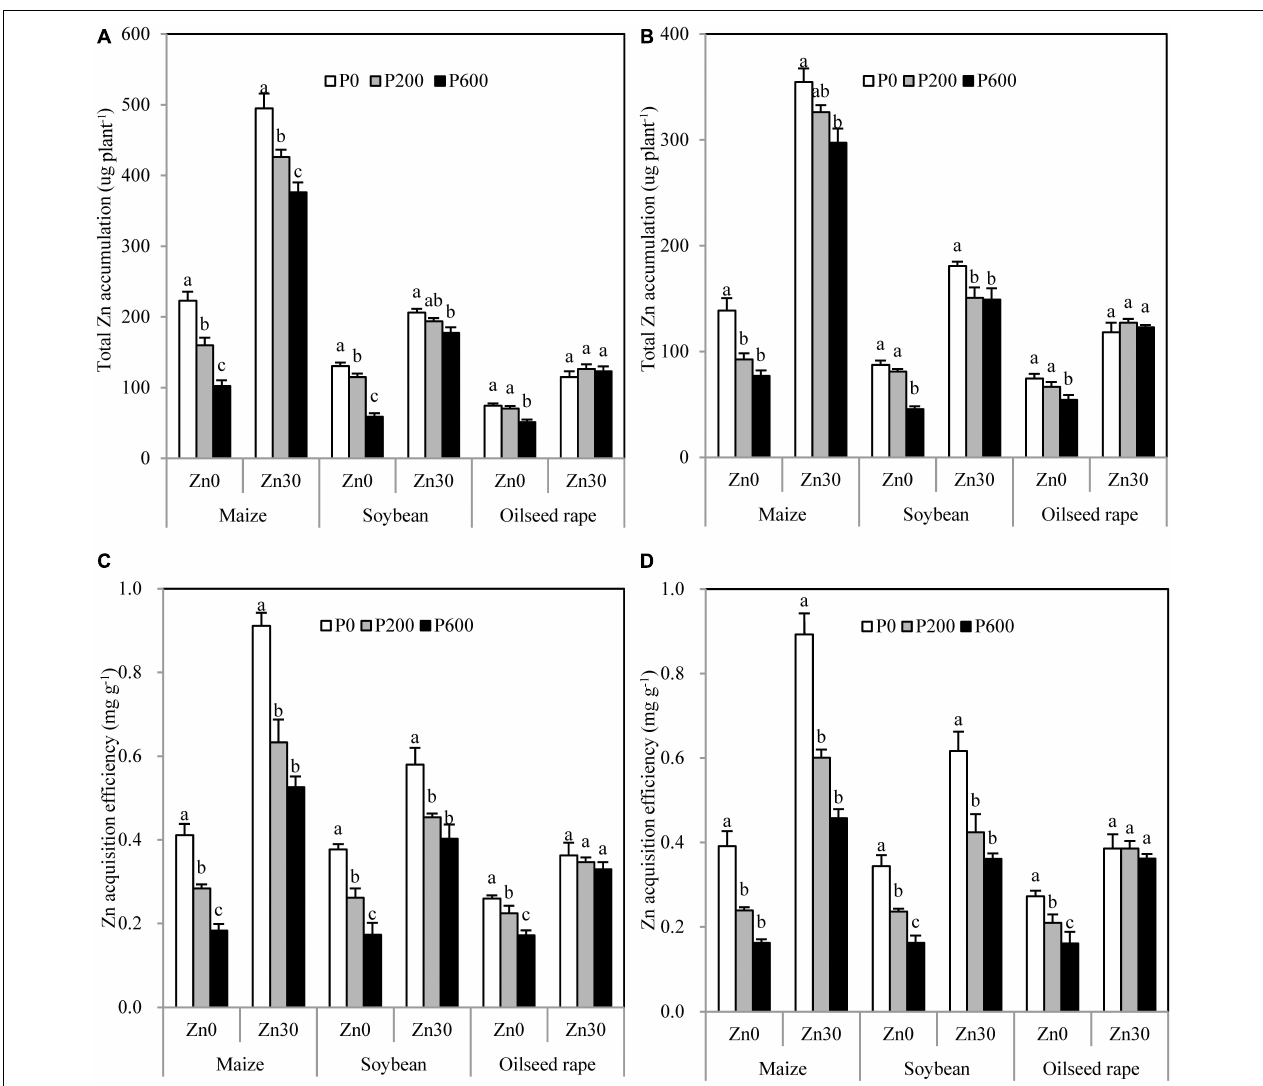
FIGURE 2 | Total Zn accumulation and Zn acquisition efficiency of maize, soybean, and oilseed rape affected by P and Zn applications without benomyl (A,C) and with 0.4 g benomyl kg − 1 soil (B,D) addition, respectively. Values are means of three replications. The same lowercase letter indicates no significant difference among P application levels ( P < 0.05). Zn0 and Zn30 represent 0 and 30 mg Zn kg − 1 soil rates, respectively. P0, P200, and P600 represent 0, 200, and 600 mg P kg − 1 soil rates,